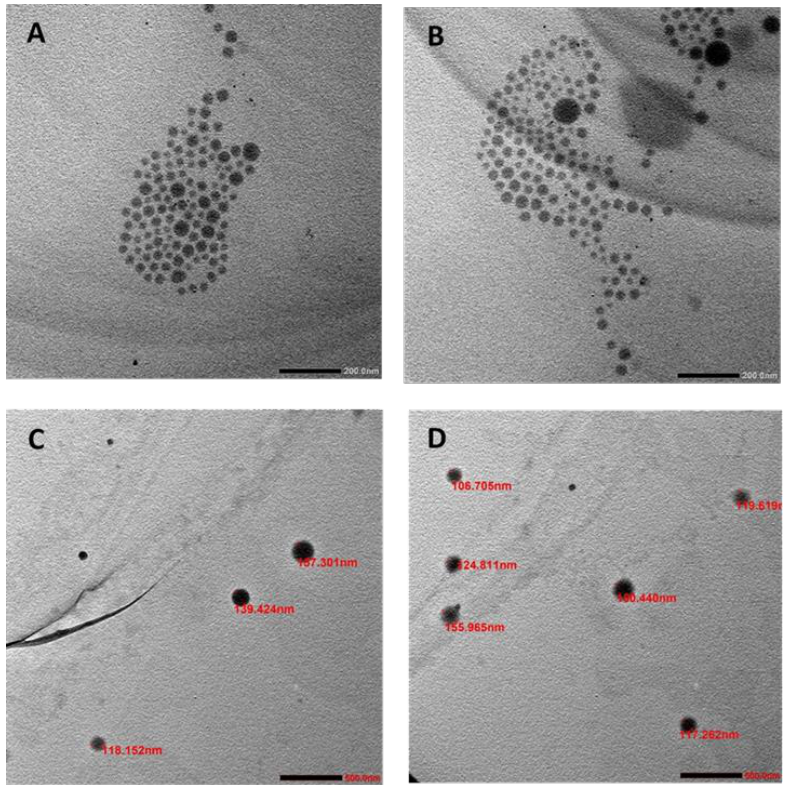
Figure 1. TEM images of ( A ) AM-PLGA-NPs ( B ) PLGA-NPs ( C ) large-scale of the AM-PLGA-NPs, and ( D ) large-scale of PLGA-NPs.